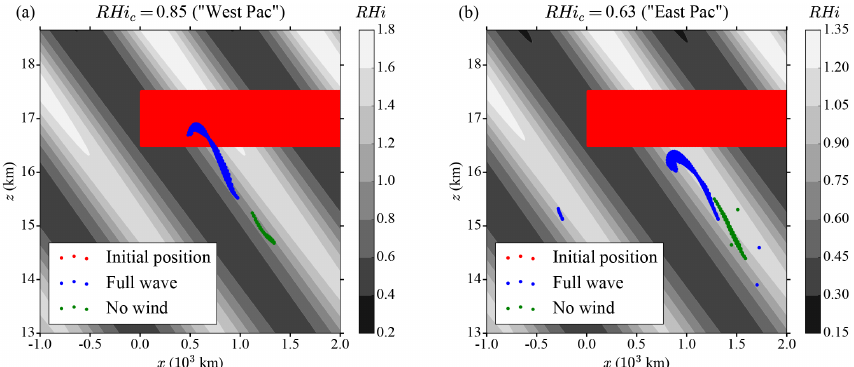
= 85% (a) and RH = 63% (b) , after half i c c